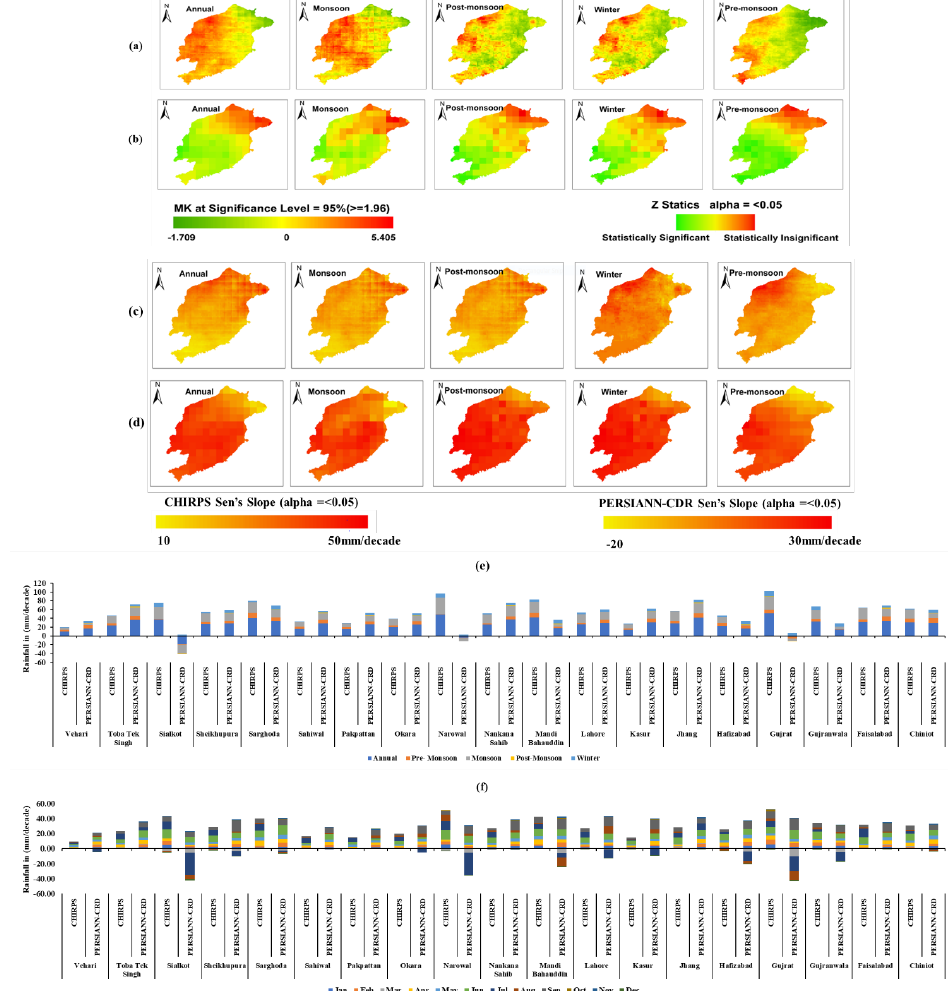
Figure 6. Spatial distribution of magnitude of trends in annual and seasonal rainfall. Top panel showing ( a ) statistical significance level of CHIRPS, ( b ) statistical significance level of PERSIANN-CDR, ( c ) magnitude of trend of CHIRPS, ( d ) magnitude of trend of PERSIANN-CDR, ( e ) annual and seasonal trends of CHIRPS and PERSIANN-CDR, and ( f ) monthly trends of CHIRPS and PERSIANN-CDR.